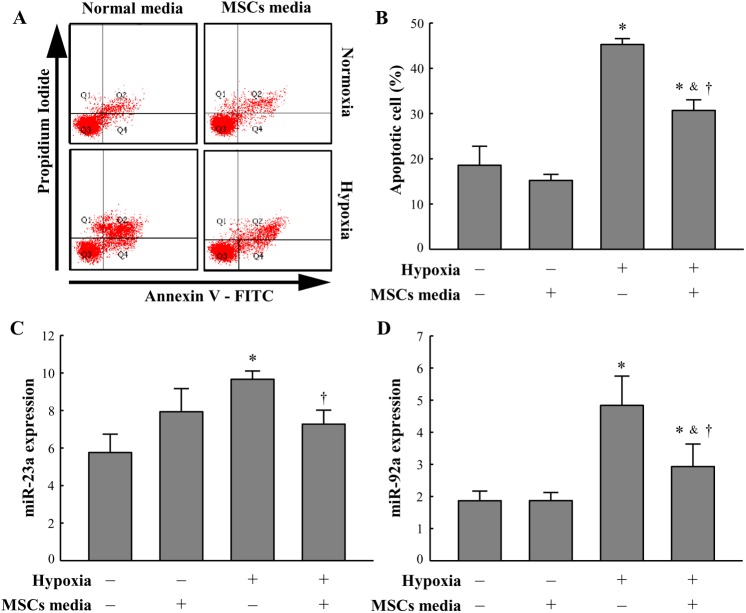
Hypoxia-exposed BM-MSC-conditioned media reduces apoptosis upon exposure of cardiomyocytes to hypoxia for 48 h.(A) Dot plots display the stages of apoptotic death of cardiomyocytes: Annexin−/PI− (Q3), viable cells; Annexin+/PI− (Q4), cells undergoing apoptosis; Annexin+/PI+ (Q2), cells that are in end-stage apoptosis or are already dead; Annexin−/PI+ (Q1), cells that are in necrosis. MSCs media indicates hypoxia-exposed BM-MSC-conditioned media. (B) Quantitative analysis of apoptotic cells (Q2+Q4). Hypoxia-exposed BM-MSC-conditioned media reduces hypoxia-induced miRNA expression in vitro. MiRNA expression was measured by real-time PCR using TaqMan probes. MiRNA-23a (C) and miRNA-92a (D) expression in response to treatment with hypoxia-exposed BM-MSC-conditioned media in comparison without hypoxia-exposed BM-MSC-conditioned media in hypoxia. All data are expressed as mean ± SD (n = 5 per group). *P < 0.05 vs. normoxia without hypoxia-exposed BM-MSC-conditioned media. &P < 0.05 vs. normoxia with hypoxia-exposed BM-MSC-conditioned media. †P < 0.05 vs. hypoxia without hypoxia-exposed BM-MSC-conditioned media.